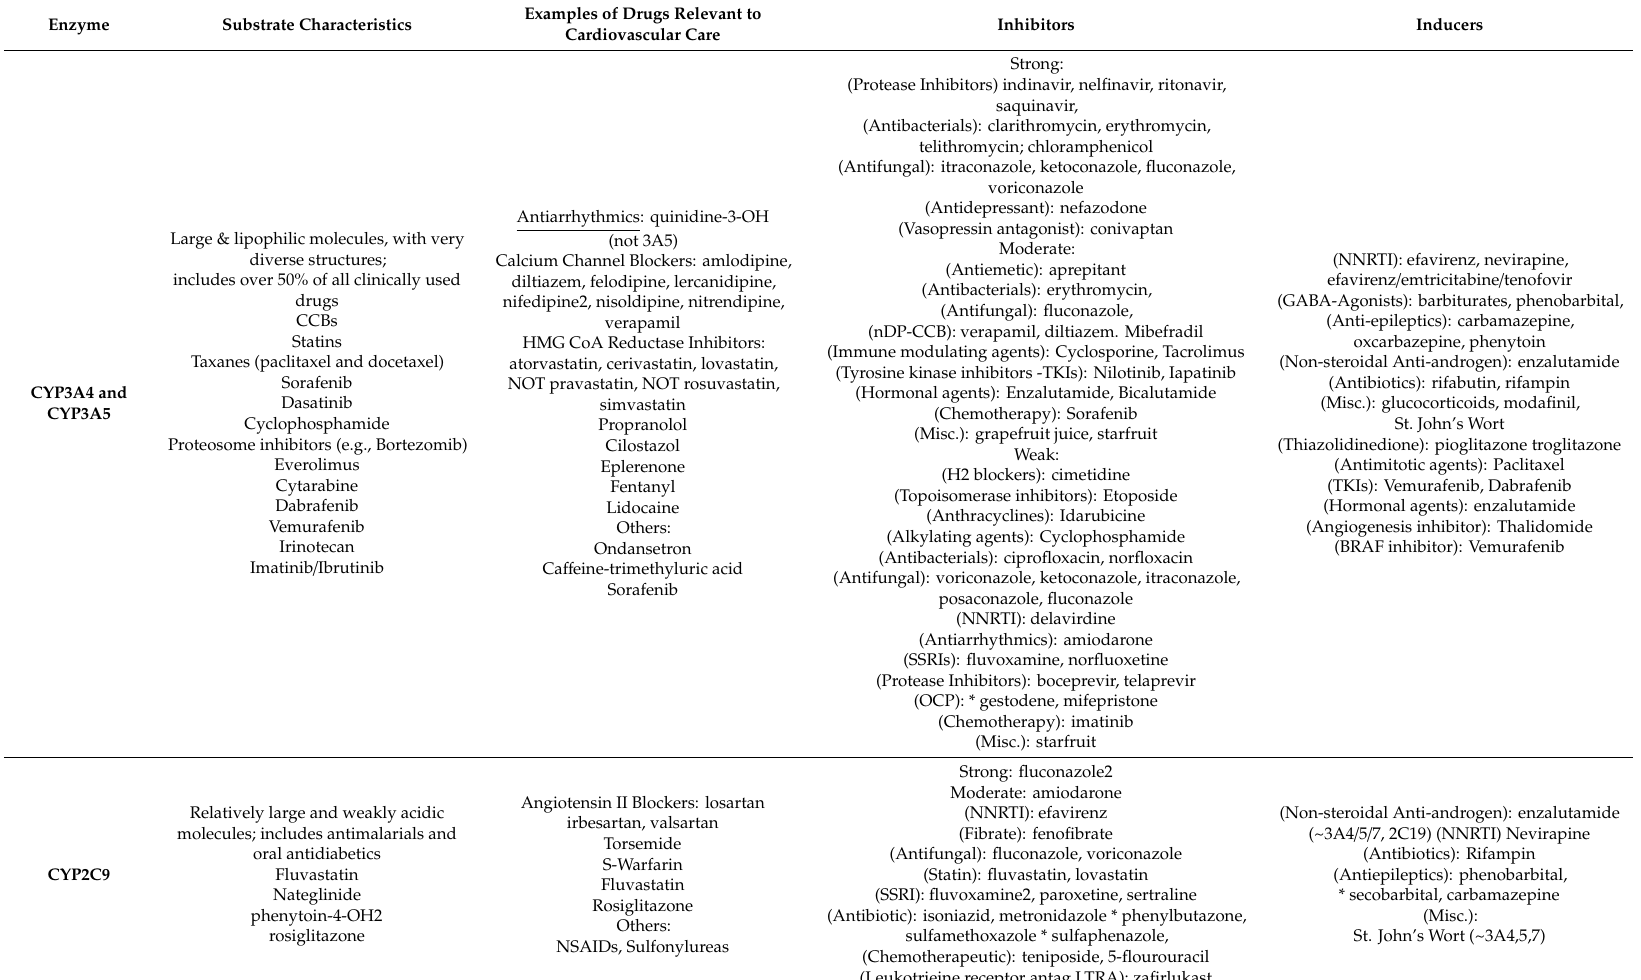
Table 2. A list of CYP450 enzymes and many of their cardiac substrates, inducers and inhibitors. Examples of Drugs Relevant to Inhibitors Inducers Enzyme Substrate Characteristics Cardiovascular Care